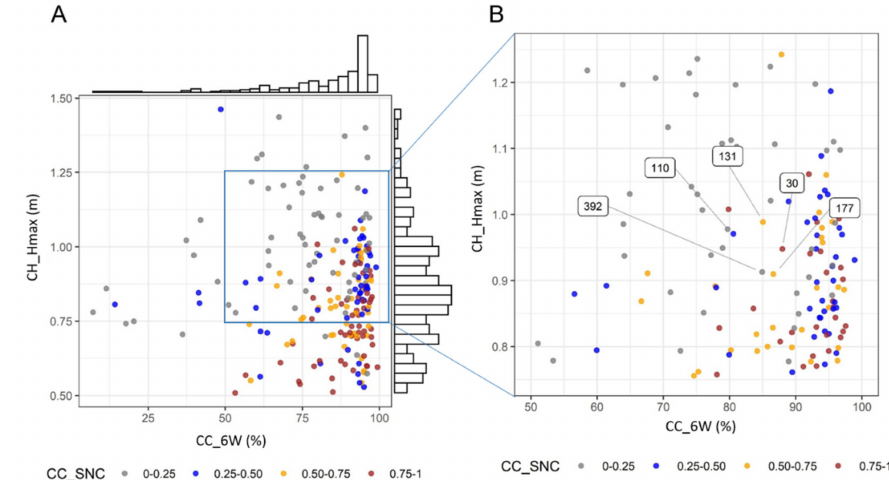
Figure 9. Representation of how data could be used to select interesting plots in a breeding program based on phenotypic data using three parameters: CC_6W, CH_Hmax, and CC_SNC ( a ). Zoom of the plot distribution based on a applicable values range for selection ( b ). For the abbreviations, see Table